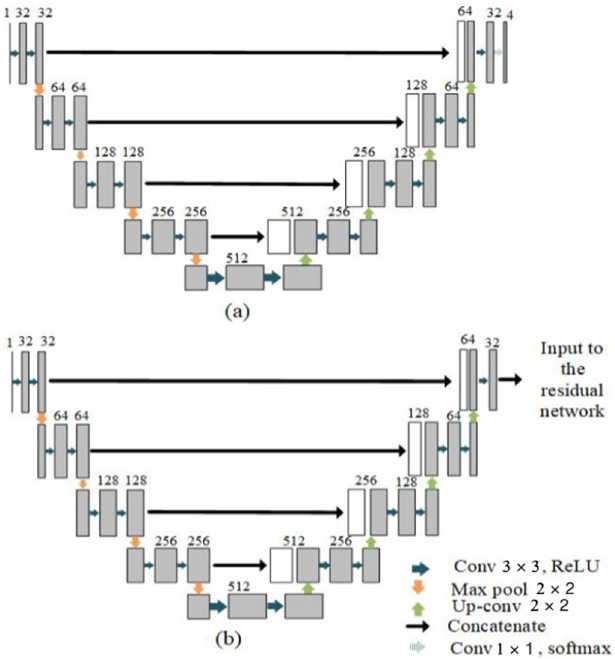
Figure 4. Architecture of single UNet for: ( a ) typical conventional segmentation and ( b ) one of the three parallel Unets which encodes and decodes one of the three slices in SIP-UNet.